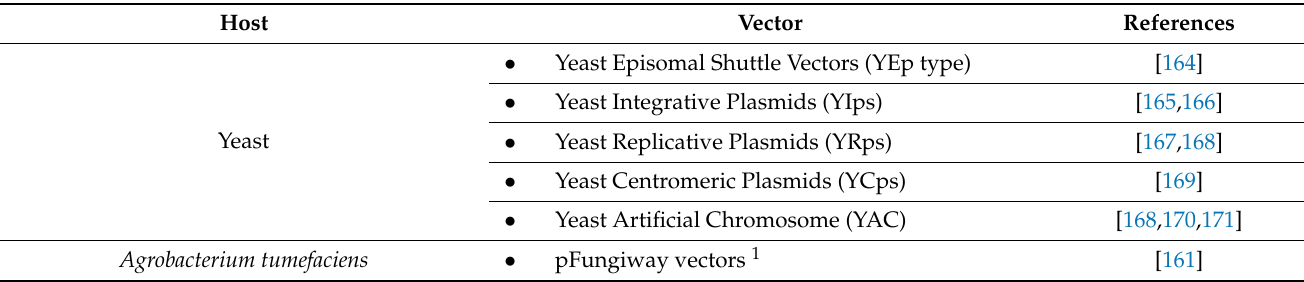
Table 2. Examples of Eukaryotic expression vectors compatible with